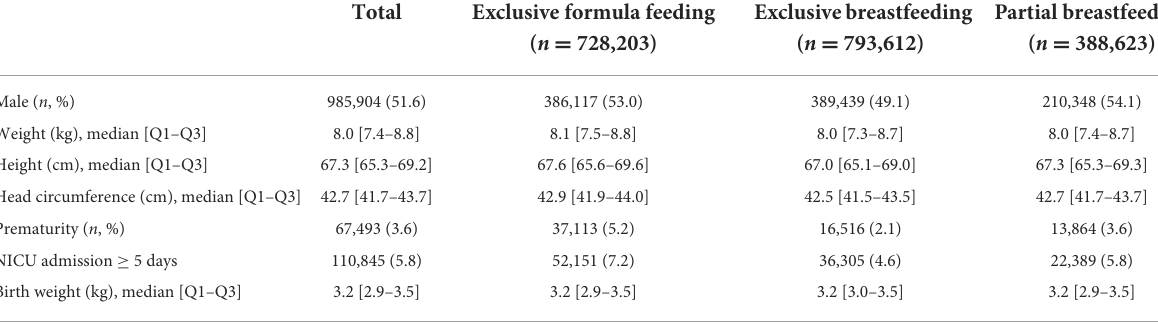
TABLE 1 Demographic characteristics of the participants according to feeding type.